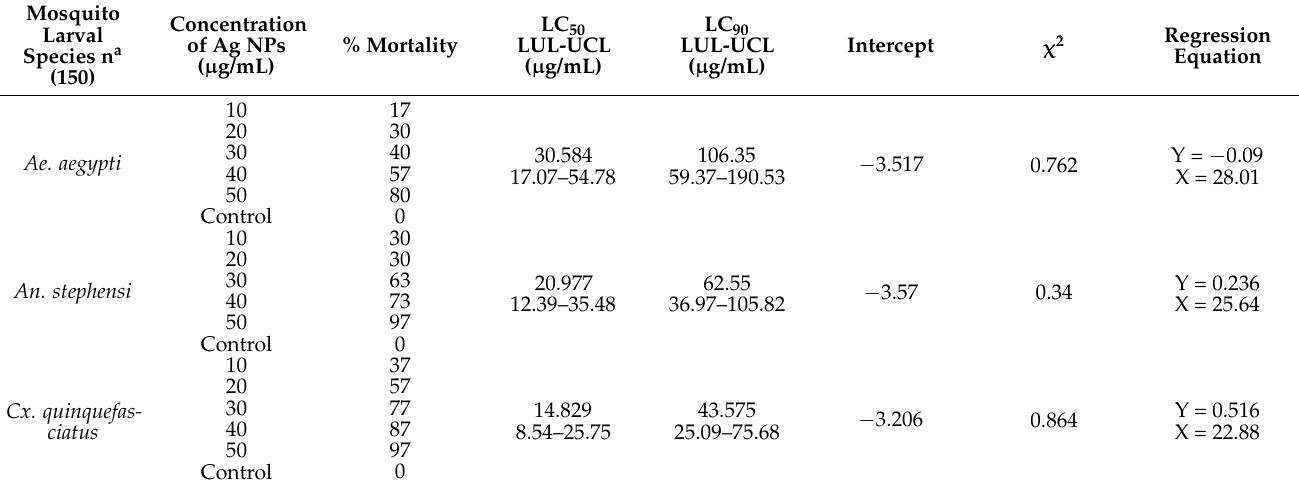
Table 1. Larvicidal activity of Pantoea stewartii -mediated Ag NPs against 4th-instar larvae of major mosquito species.